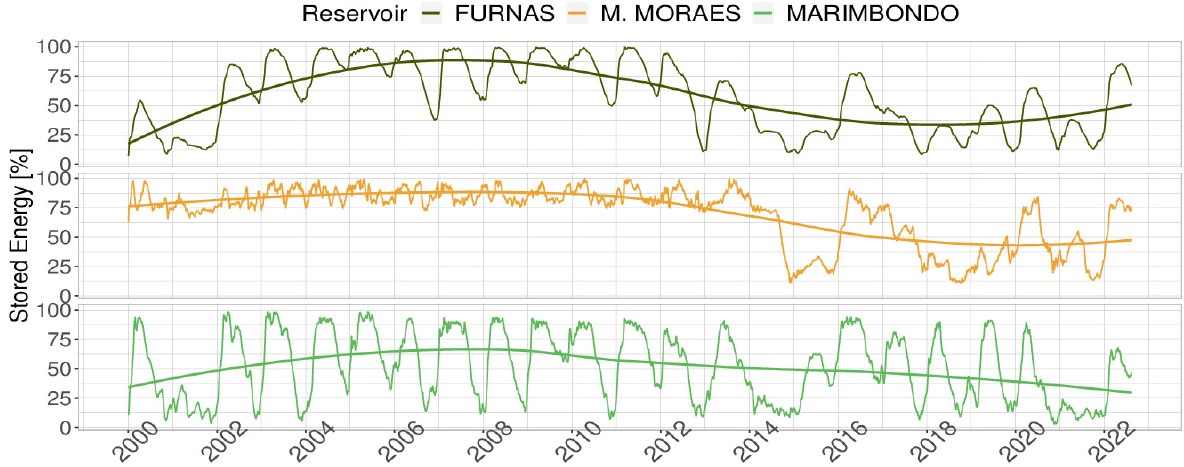
Figure 1. Stored Energy (STE)—Historical Series of Furnas, Mascarenhas de Moraes and Marimbondo Hydroelectric Power Plants (HPPs).